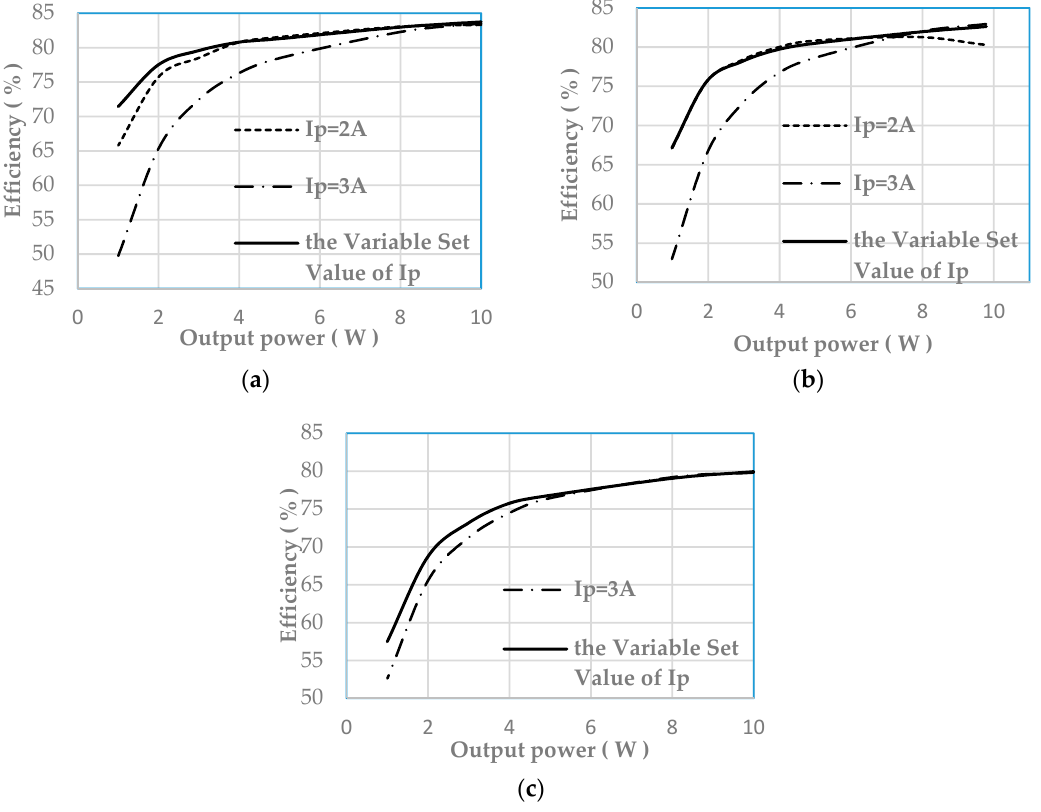
Figure 8. Comparison of efficiencies at different primary currents: ( a ) vertical distance of coils is 1.2 cm ( k = 0.51); ( b ) vertical distance of coils is 1.5 cm ( k = 0.40); ( c ) vertical distance of coils is 1.8 cm ( k = 0.31).